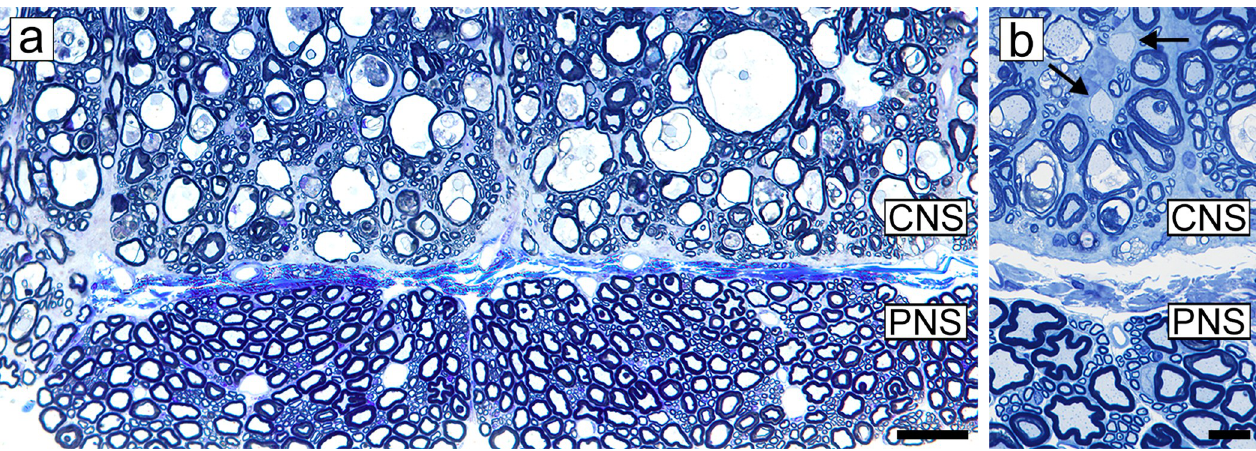
Fig 3. Peripheral myelin is unaffected in FIDID. a, b) The ventral column of two cats with FIDID and adjacent nerve roots show the difference between the CNS and PNS. No evidence of myelin sheath vacuolation is seen in the PNS while it is extensive in the CNS. b) Myelin vacuolation and demyelination (arrows) are evident. Scale bar: 20 μ m (b). 100 μ m